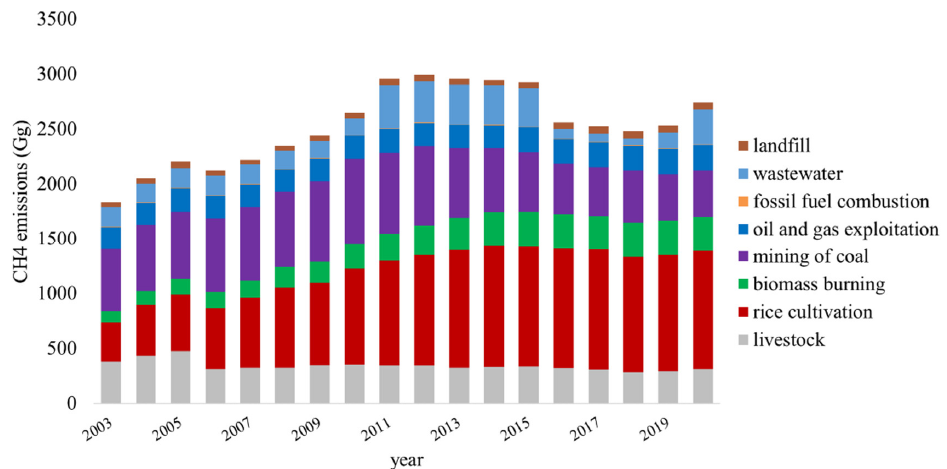
Figure 1. Total CH 4 emissions in the Heilongjiang province.